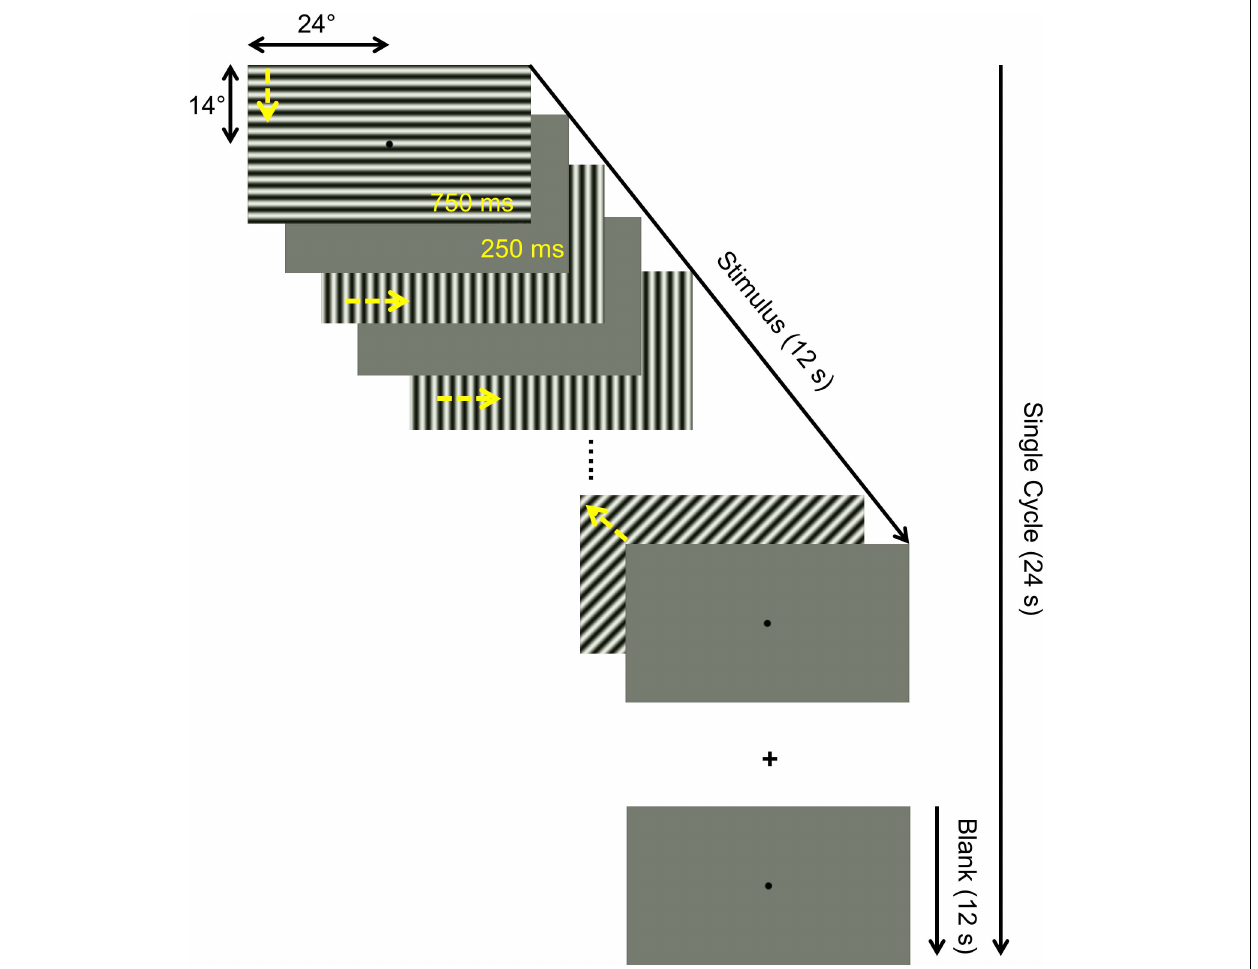
FIGURE 1 | Illustration of temporal sequence of a single stimulus cycle. Each 24 s cycle comprised a 12 s motion block (drifting patterns) block and a 12 s mean blank block (mean luminance gray). A total of 10 cycles were presented per fMRI run, resulting in a total duration of 240 s. The motion block consisted of 12 1-s trials comprising 750 ms motion stimulus (drifting in one of 8 different directions, as indicated by yellow arrows added for visualization) and 250 ms mean luminance gray. Identical stimuli were presented for three different task conditions in separate fMRI runs: (i) passive viewing (PV), (ii) one-back task (OBT), (iii) fixation-dot task (FDT), as detailed in section “Materials and